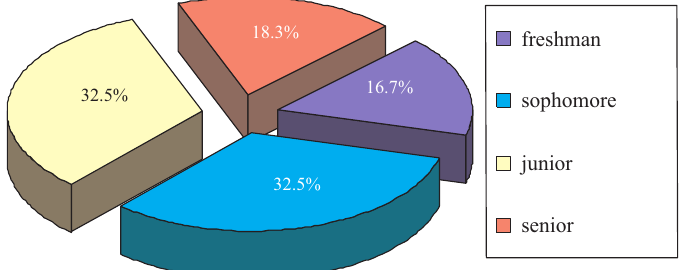
Figure 1. Grade distribution of